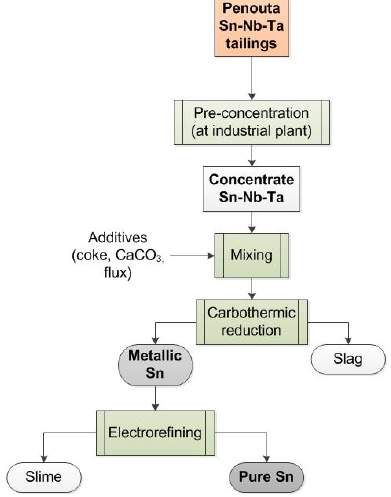
Figure 2. Process followed from tailings to recovery of pure Sn.